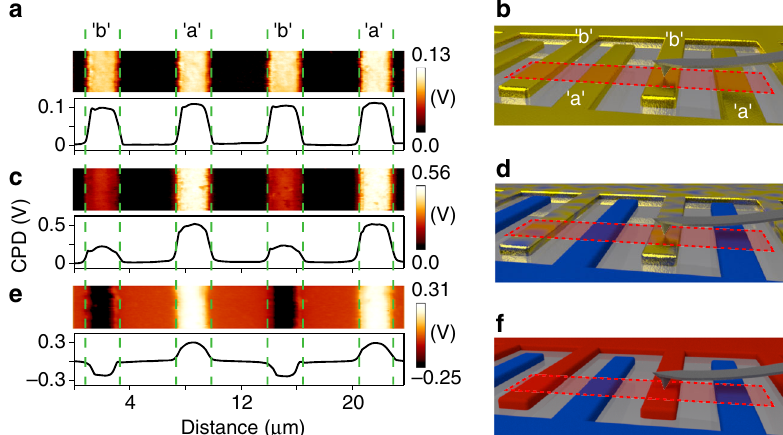
Fig. 1 Kelvin-probe-force-microscopy of an interdigitated gold microelectrode array during molecular modi fi cation. Contact potential difference (CPD) maps across sets of interdigitated fi ngers and illustrations of the KPFM imaging experiment for an unmodi fi ed IDA a + b , an IDA after exposure to 4- methoxythiophenol (OMeTP) and its subsequent electrochemical desorption from electrode “ b ” c + d , and an IDA after the fi nal modi fi cation step with 4- chlorothiophenol (ClTP) e +